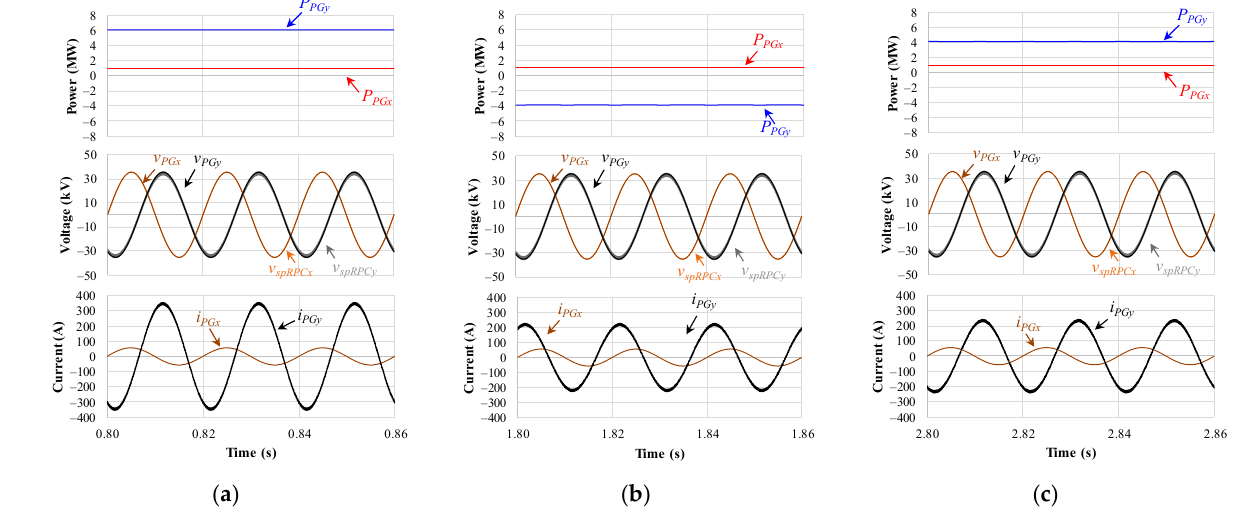
Figure 12. Simulation results of the power in each TPS, P PGx and P PGy , the voltages, v PGx , v PGy , v spRPCx and v spRPCy , and currents, i PGx and i PGy , for di ff erent load conditions: ( a ) P Loadx = 0.998 MW and P Loady = 6.12 MW; ( b ) P Loadx = 0.998 MW and P Loady = − 3.88 MW; ( c ) P Loadx = 0.998 MW and P Loady = 4.12 MW.